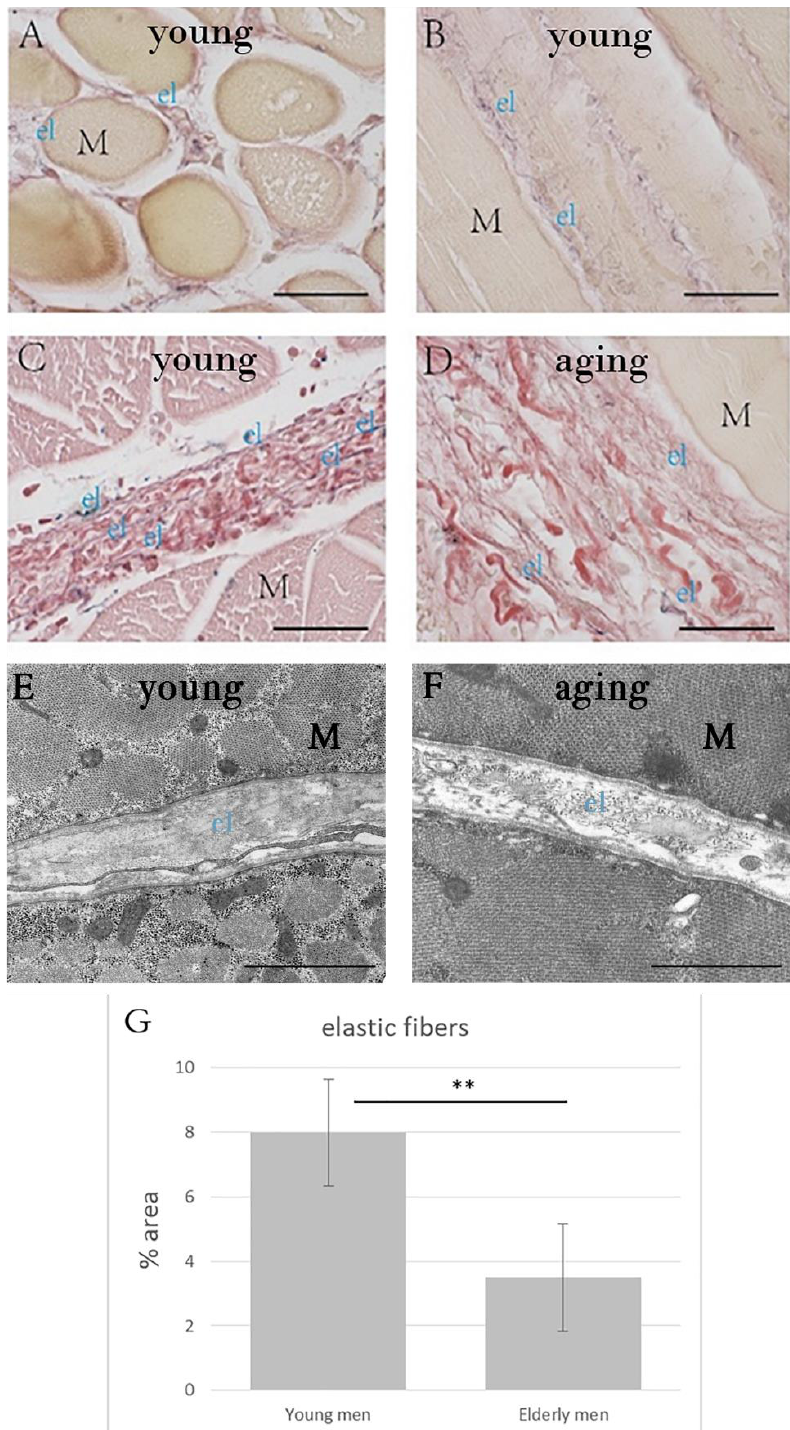
Figure 3. Weigert Van Gieson staining ( A – D ) of human muscle samples, from a 49 year old man ( A , B ), 18 year old man ( C ), 94 year old man ( D ). ( E , F ) show TEM images from 27 year old man ( E ) and 74 year old man ( F ). The amount of elastic fibers was significantly higher in young men with respect to elderly men ( G ) (** p = 0.01). M = muscle cell; el: elastic fibers (black-violet color) in the endomysium ( A , B ) and perimysium ( C , D ). ( A – D ): Scale bar: 50 μ m. ( E , F ): Scale bar: 1 µm.